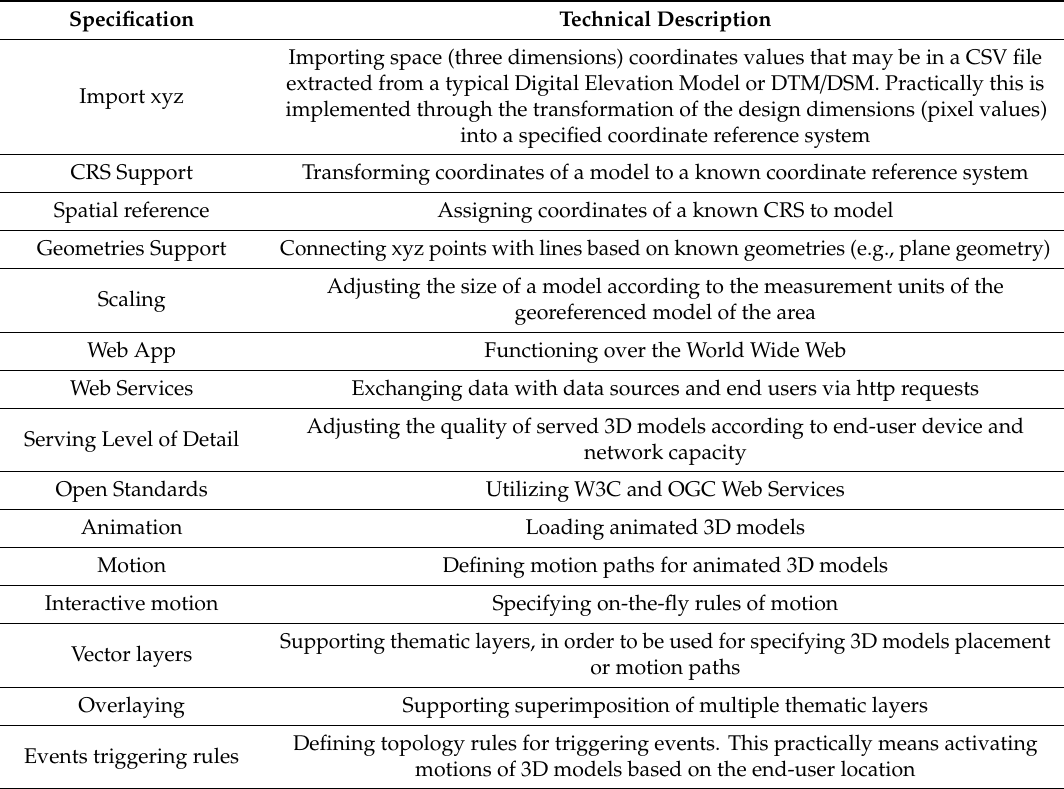
Table 2. Specifying “Mergin’